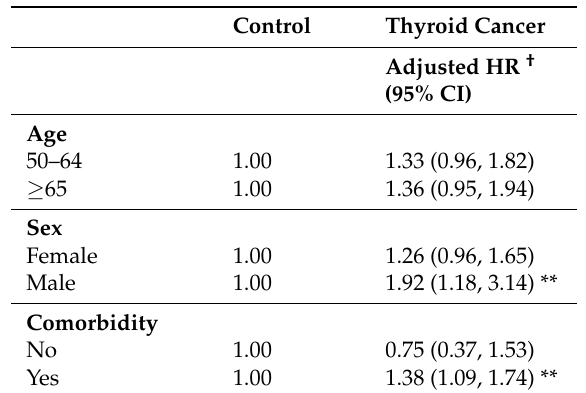
Table 3. Adjusted hazard ratios (HR) for macular degeneration according to thyroid cancer status stratified by age, sex, and comorbidity.